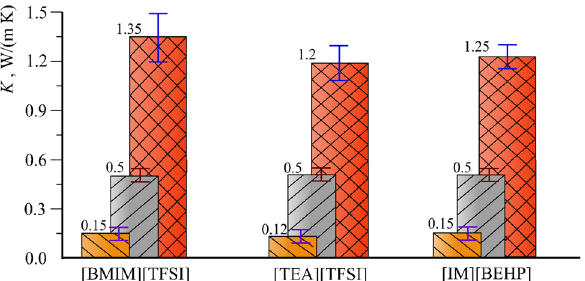
Figure 4. Thermal conductivity of IL (\\\-line hatched columns), PSi (///-line hatched columns), "PSi/IL" composite system (#-line hatched columns).